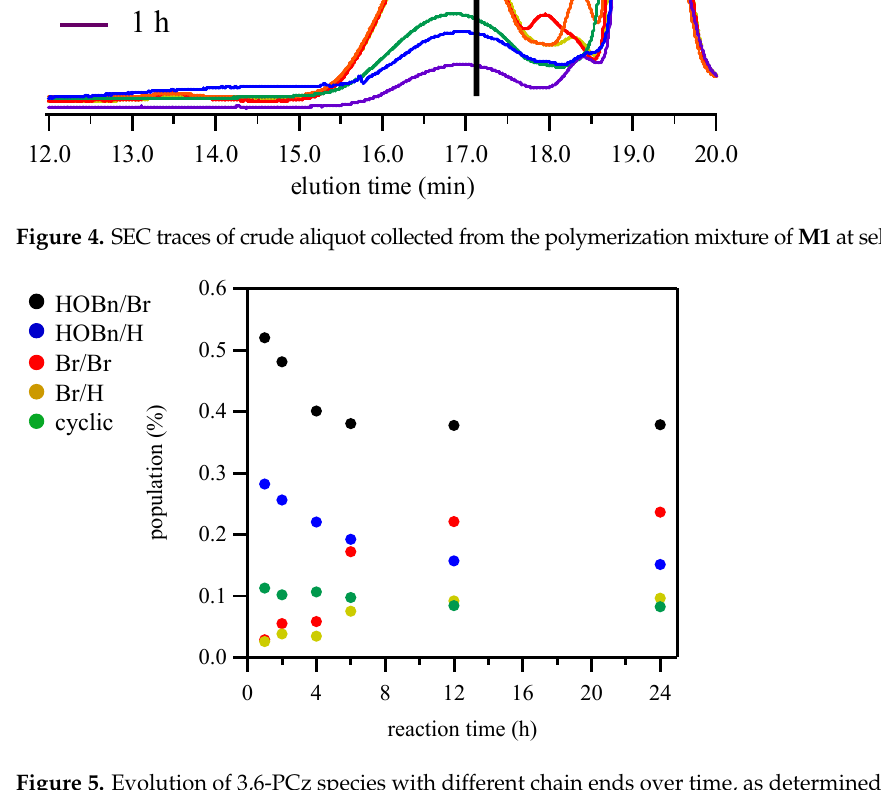
Figure 5. Evolution of 3,6-PCz species with different chain ends over time, as determined by MALDI-TOF MS analysis.